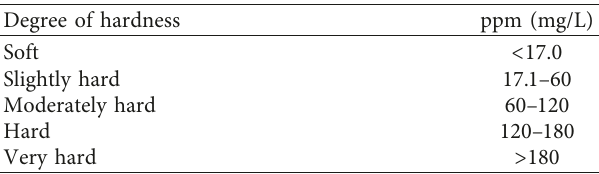
Table 4: The degree of water hardness based on the American Society of Agricultural and Biological Engineering (No. S-339) [38].